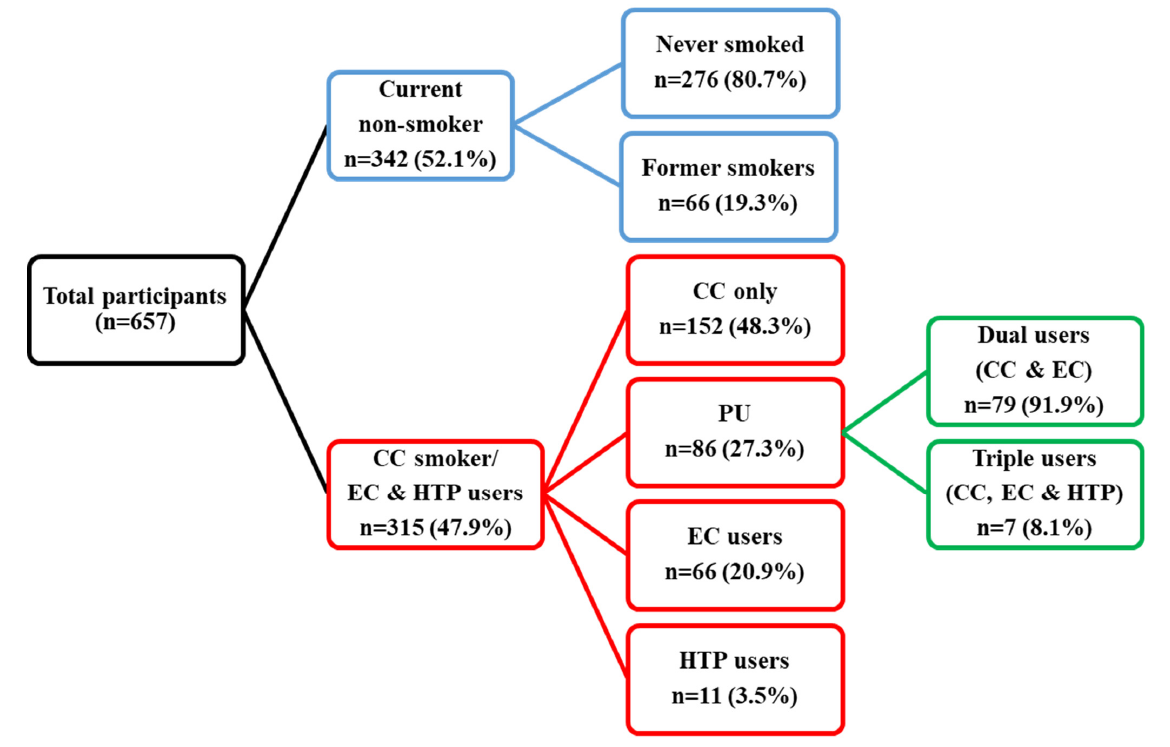
Figure 1. Description of current smoking status among participants.